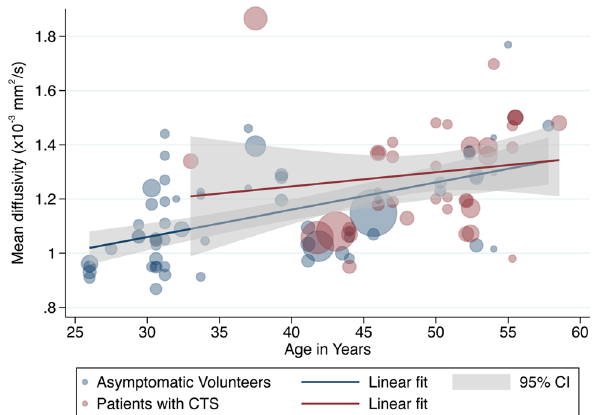
Figure 5. A scatterplot of study-level estimates of mean diffusivity in asymptomatic adults and patients with carpal tunnel syndrome, against age in years. The size of the points corresponds to the precision (inverse variance) of the study.